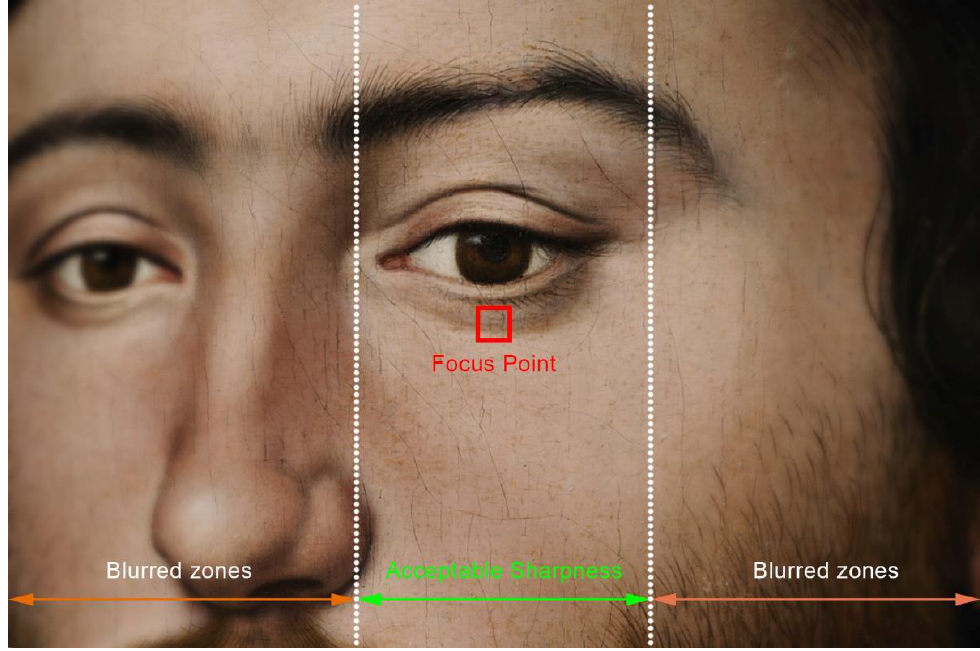
Figure 4. Loss of sharpness in an oblique shot due to narrow depth of field of long focal lenses.